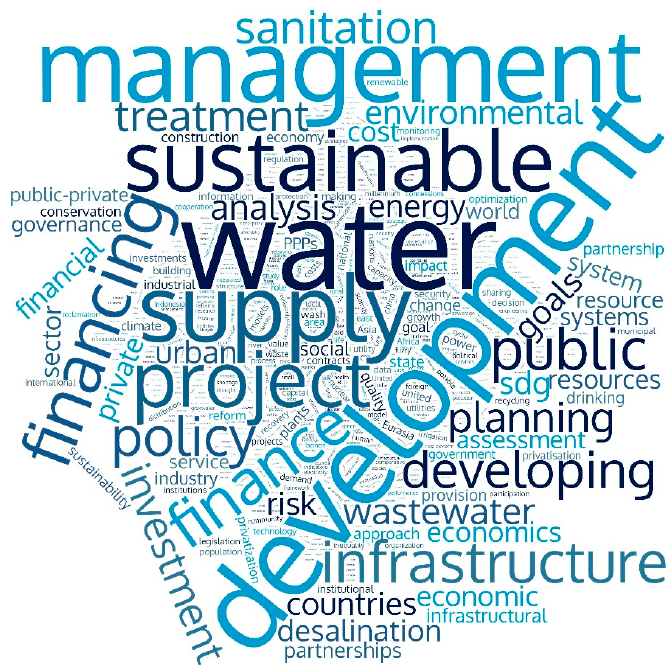
Figure 5. Research topics’ word cloud.